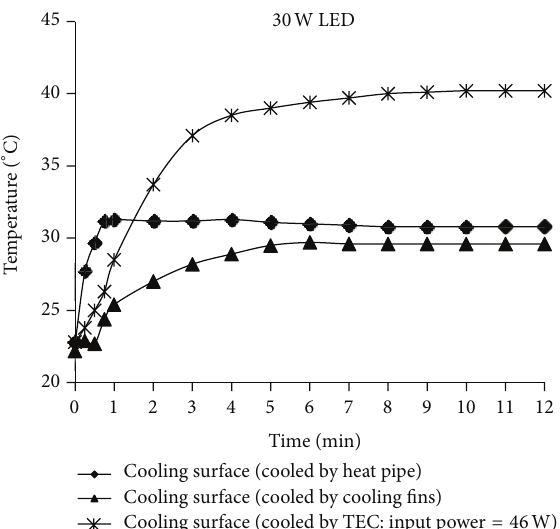
Figure 12: The temperature-time graphics of three different cooling systems used to cool LEDs with 30 W LED